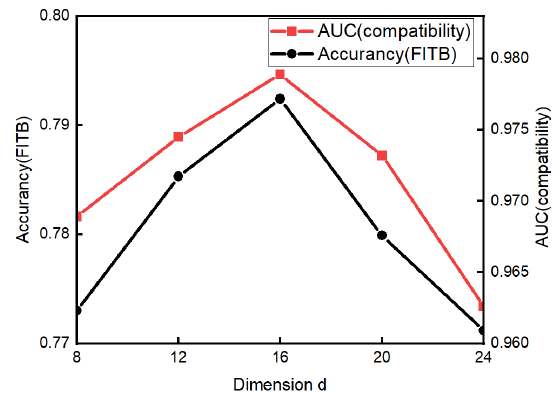
Figure 7. Test performance in different